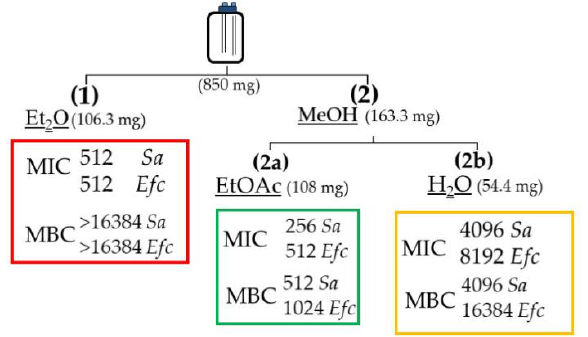
Figure 3. Representative scheme of Stage-1: three extracts obtained from Amphidinium carterae LACW11 biomass (freeze dried, mg) were screened against Gram-positive bacteria. Activities are expressed in µg/mL. Sa , Staphylococcus aureus ATCC 25,293; Efc , Enterococcus faecalis ATCC 29,212. The bioactivities of each extract are highlighted with different colours.